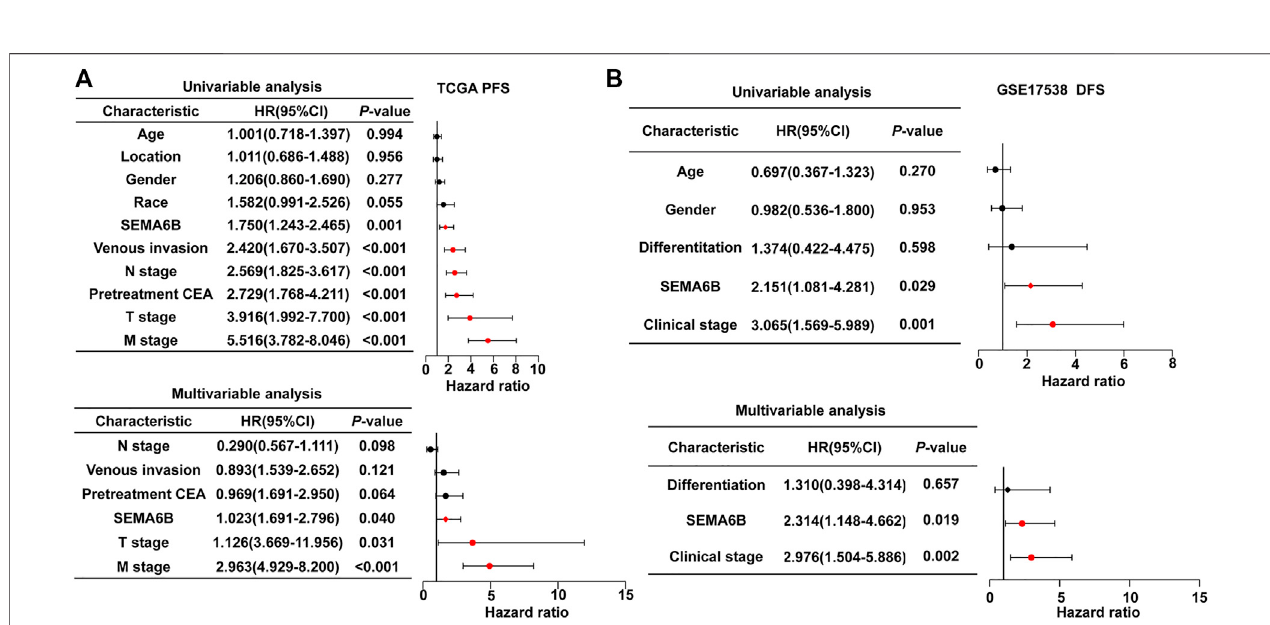
FIGURE 3 | Kaplan-Meier survival analysis comparing high and low expression of SEMA6B in patients with CRC. (A) Survival curves of overall survival (OS), 5 year survival, disease-free survival (DFS), and progression-free survival (PFS) in the TCGA dataset. (B) Survival curves of OS and relapse-free survival (RFS) in the validated GEO dataset (GSE39582).